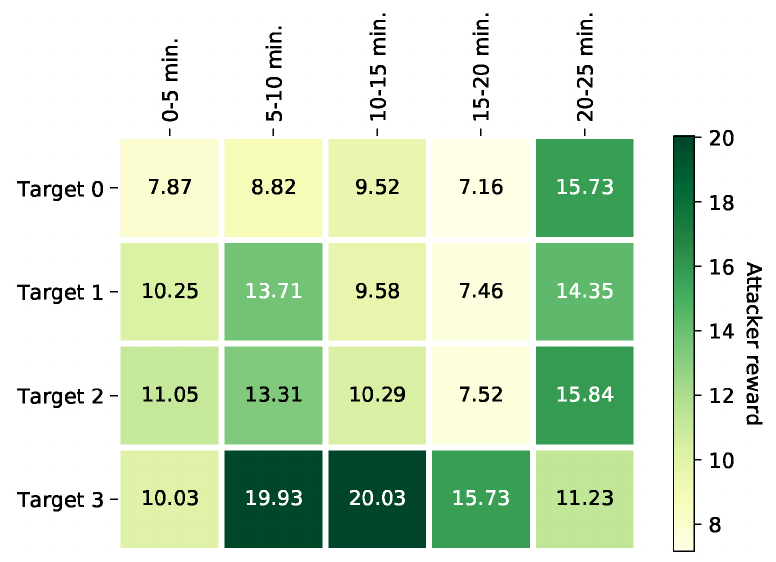
Figure 7. Attacker reward values for each attacking strategy, when the defender performs the optimal patrol illustrated in Figure